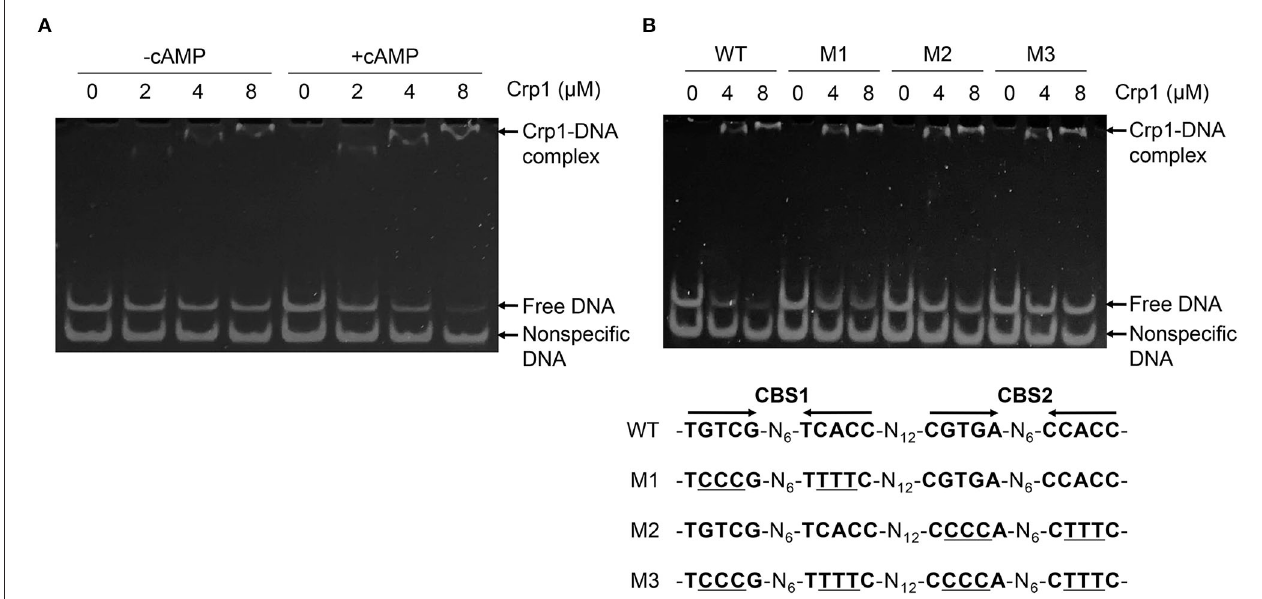
FIGURE 5 | Binding of Crp1 to the cydA control region. (A) EMSA showing the effect of cAMP on the binding of Crp1 to the upstream region of cydA . The mixtures of 99-bp DNA fragments (70 fmol) containing two Crp-binding sites (CBS1 and CBS2) upstream of cydA and 80-bp non-specific DNA fragments without the Crp-binding site (100 fmol) were incubated with increasing concentrations of purified Crp1 in the presence and absence of 200 µ M cAMP. (B) 99-bp DNA fragments (70 fmol) containing either WT or mutated Crp-binding sites (M1, M2, and M3), as well as 80-bp non-specific DNA fragments without the Crp-binding site (100 fmol), were mixed with increasing concentrations of purified Crp1 in the presence of 200 µ M cAMP. The Crp1-DNA reaction mixtures were subjected to native PAGE. The concentrations of Crp1 used in EMSA are given above the lanes. The concentration of Crp1 refers to that of the Crp1